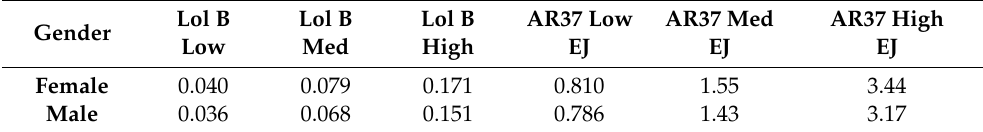
Table 1. Dose rate of lolitrem B or epoxyjanthitrems (mg/kg/day) consumed for 90 days.